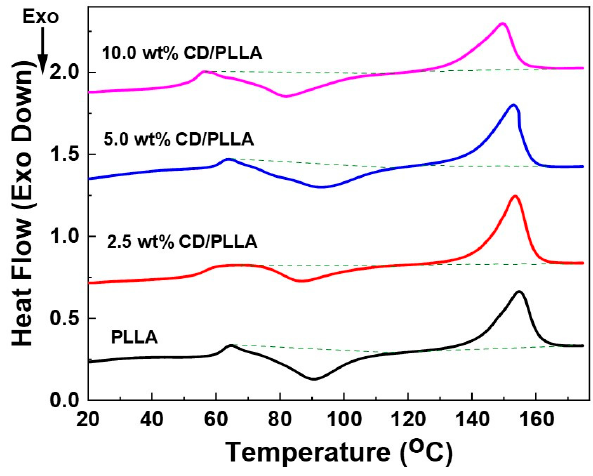
Figure 6. DSC thermograms of PLLA and CD/PLLA nanofibers. Table 2. Summary of T g , enthalpy at T g , Tm, and enthalpy at T m of PLLA and CD/PLLA nanofibers.